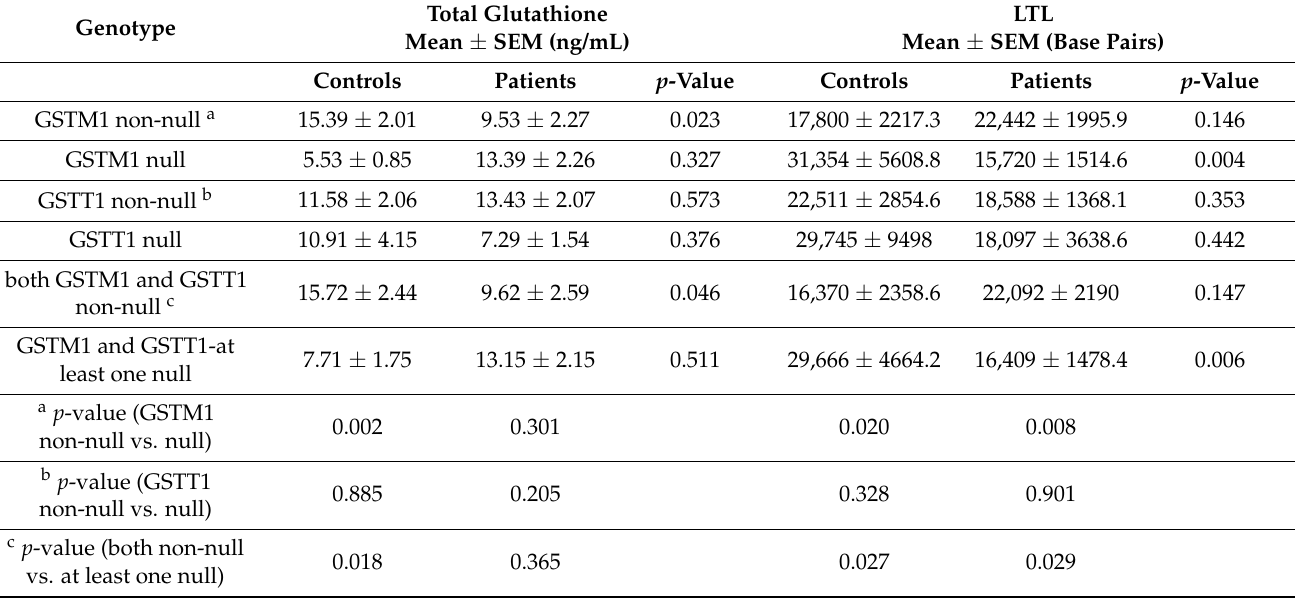
Table 4. Concentration of total glutathione in the serum (ng/mL) and the LTL (bp) in controls and COPD patients. Data are presented as mean ±